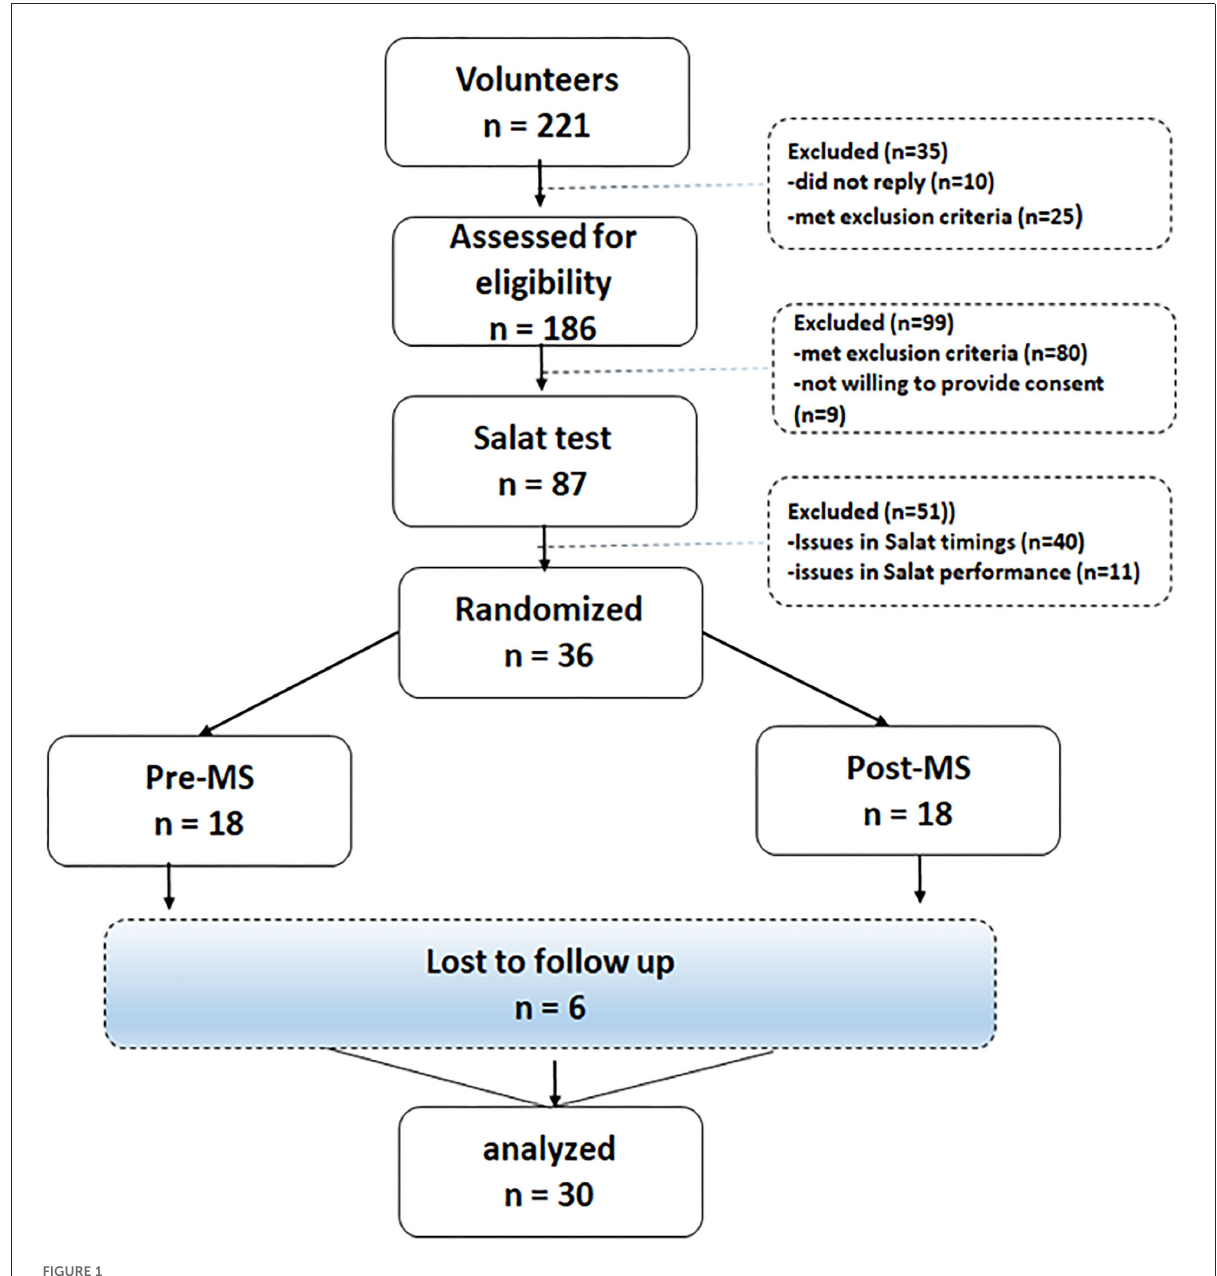
FIGURE1 Participant’s flow